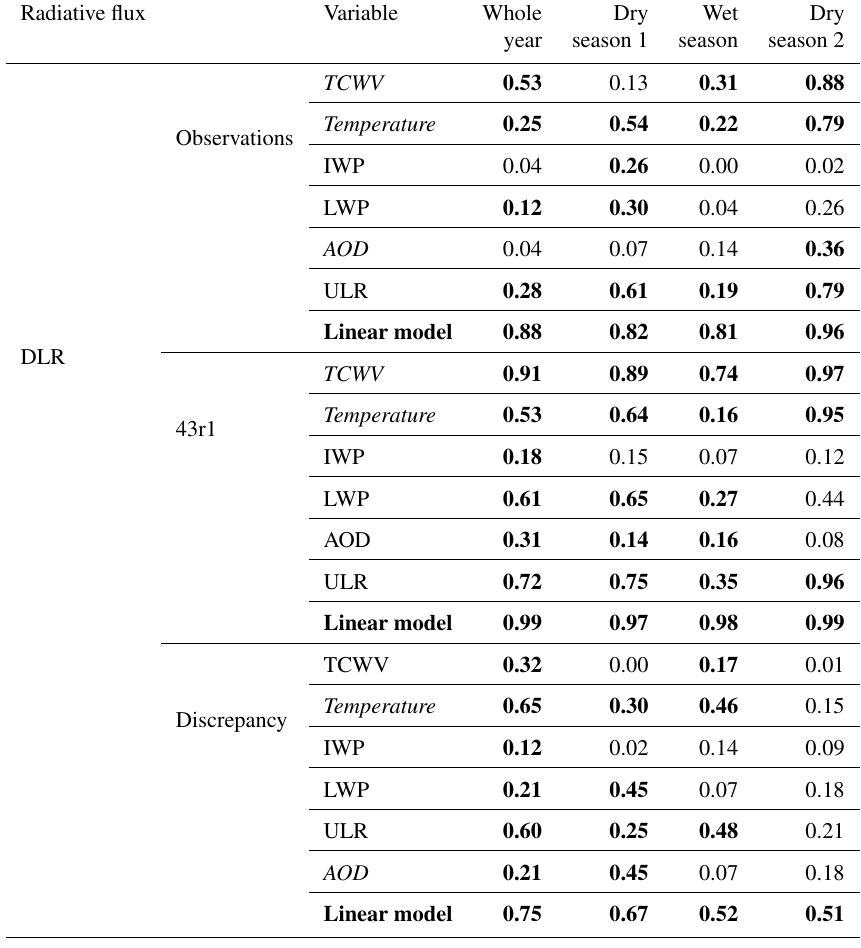
Table 5. Downwelling longwave surface fluxes: r 2 values from correlations between observed and 43r1 DLR, and their discrepancy, to other variables for the whole year (days 7–341), first dry season (days 7–125), wet season (days 126–301) and second dry season (days 302–341); statistically significant (to p ≤ 0.001) values are in bold. Italics indicate which variables were used in the linear